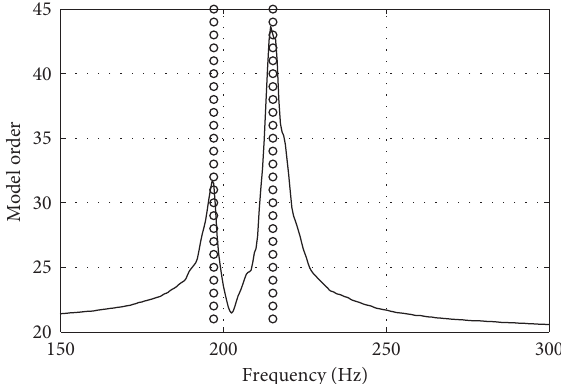
Figure 19: Variation of the identified frequencies (below 400Hz) with model order for damage case ① .